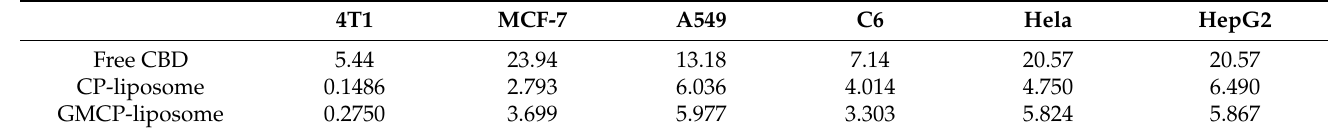
values (Figure S2a,b) of the CP-liposome and GMCP-liposome were nearly unchanged in normal saline, 5% glucose solution, PBS (pH = 7.4), simulated gastric fluid (SGF), simulated intestinal fluid (SIF) and plasma, and no aggregation was observed, indicating good Figure 3. Particle size distribution of CP-liposome ( a ) and GMCP-liposome ( b ), and transmission suitability for intravenous injection and oral administration. electron microscopy images of CP-liposome ( c ) and GMCP-liposome ( d ). Table 1. IC 50 values ( µ g/)mL of free CBD, CP-liposome, and GMCP-liposome against different tumor Table 1. IC 50 values (µg/)mL of free CBD, CP-liposome, and GMCP-liposome against different tu- cell lines after 72 h incubation (n = 5). mor cell lines after 72 h incubation (n = 5).